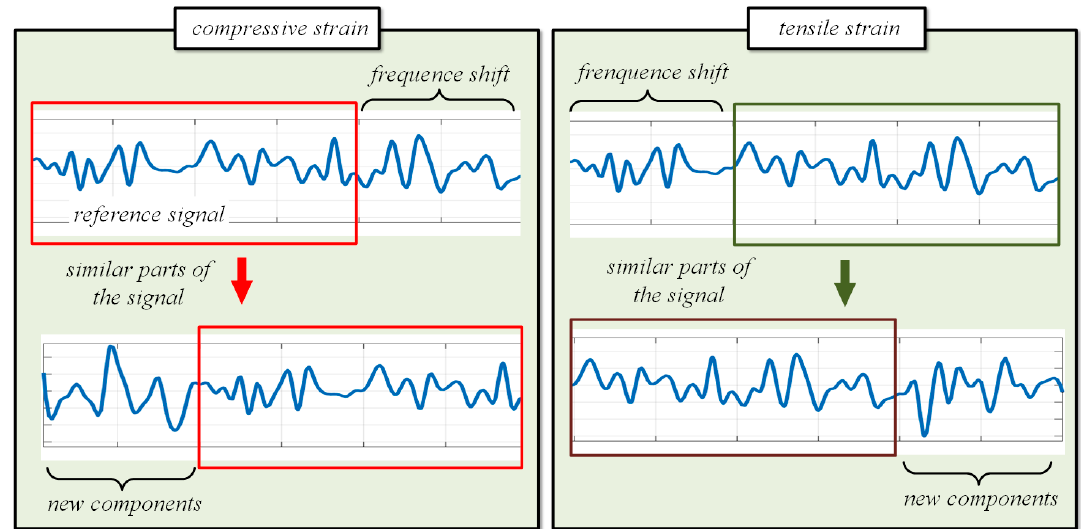
Figure 2. Schematic diagram of spectrum shift. Tensile and compressive strains cause a frequency shift, which can be solved using cross-correlation operation. The new components in the diagram are introduced by the shift. The longer the length of the new component, the shorter the length of the similar parts of the signal, resulting in the failure of the cross-correlation operation.